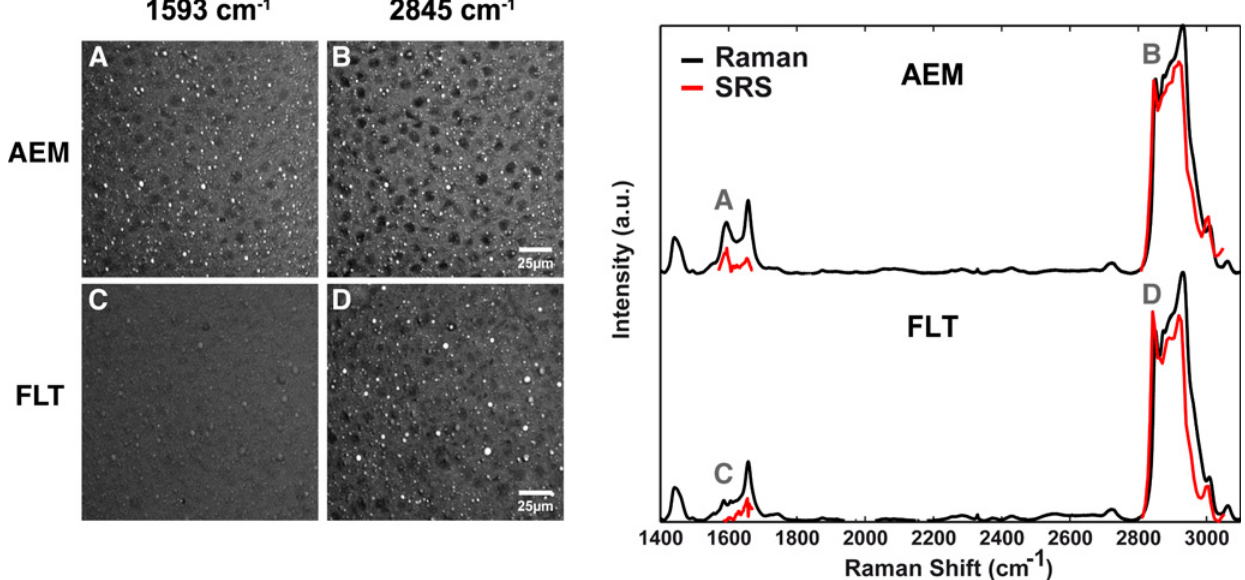
Fig 4. Remodeling of the ECM is increased in livers from spaceflight mice. Fixed tissues were stained for PLIN2 (green) and ACTA2 (red) and nuclei were stained with DAPI (blue) to visualize lipid droplets and markers of activation in stellate cells ( A , E ). Mouse liver tissues were either fixed as described in Materials and Methods and stained with Picrosirius Red ( B , C , F , G ) or flash frozen and cryosectioned ( D , H ). Collagen staining was observed in Picrosirius Red stained sections ( B , F ) primarily near the portal triad (PT) and central vein (CV) areas. Using cross-polarized light, signal was more readily observed ( C , G ). SHG imaging was performed on cryosectioned samples ( D , H ) and increased collagen signal in interstitial regions was observed in livers from FLT mice as compared with AEM controls. Representative images are shown from each group ( n = 3 – 5 mice/group). Magnification is 200× for stained samples and 60× for SHG images. Transcriptomic analysis reveals that expression levels of several important modulators of ECM remodeling are changed in spaceflight ( I ). Values are mean ± SEM; * P < 0.05. n = 5 – 6 / group.